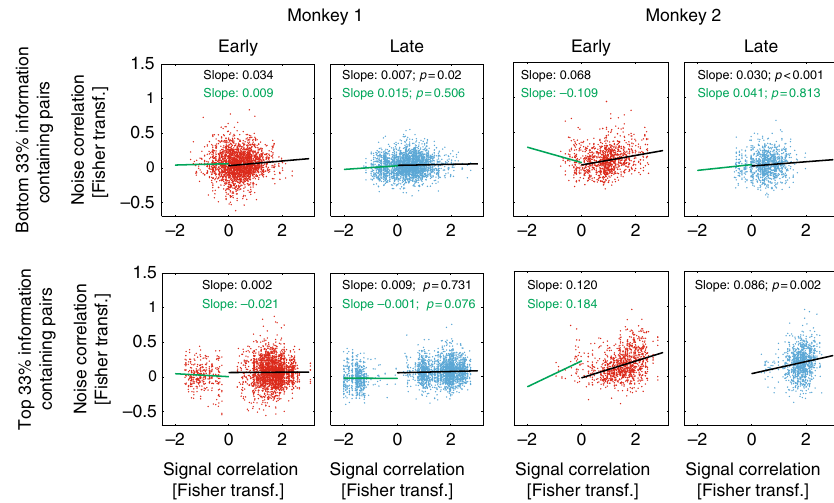
Fig. 8 Relation between signal and noise correlation during early and late stages of learning. Top row: Signal vs. noise correlation for channels that encode relatively little information for early (left columns for each monkey) and late (right columns for each monkey) recording sessions. Bottom row: Signal vs. noise correlation for channels that encode large amounts of information for early (left columns for each monkey) and late (right columns for each monkey) recording sessions. Linear regressions between signal and noise correlations (Fisher transformed) were calculated separately for pairs with positive signal correlation and for pairs with negative signal correlation. Slopes for these calculations are given in each subplot (black: positive signal correlations, green: negative signal correlations). p Values indicate whether slopes for the late sessions were signi fi cantly different from those for the early sessions (permutation test). Red data points show signal vs. noise correlation distributions from early sessions (at the start of learning), blue data points the respective distributions from late sessions (after